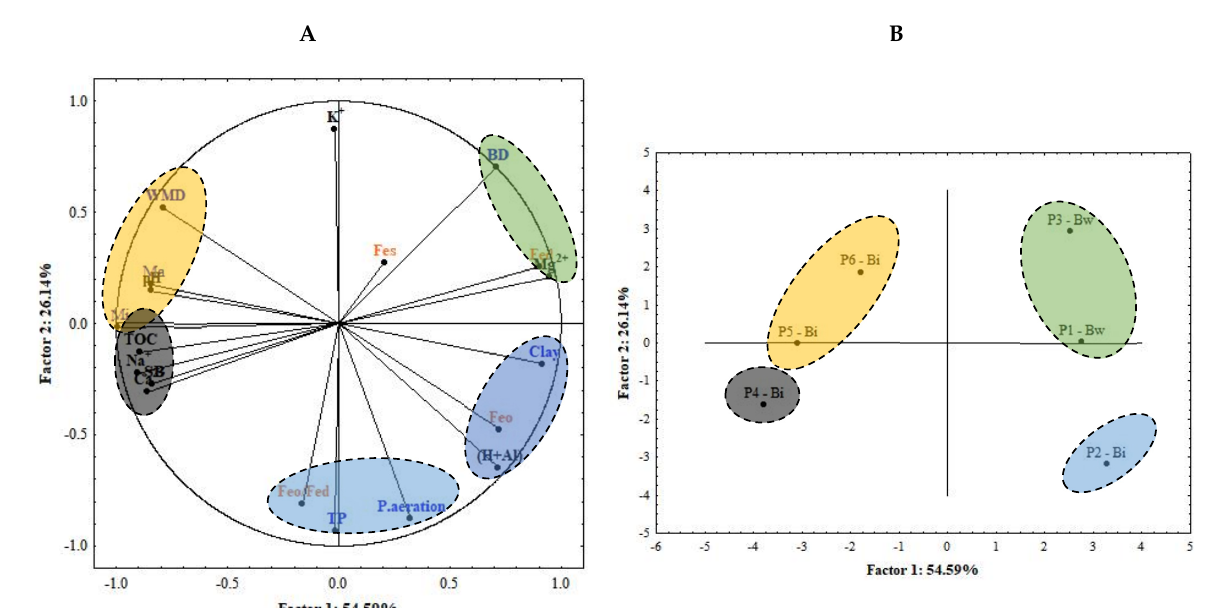
Figure 5. Cloud distribution of ( A ) variables in the correlation circle ( B ) points representing the relates between factors 1–2 and the environments studied. Similar colors represent profiles and their diagnostic horizons and the discrimination of soil attributes.